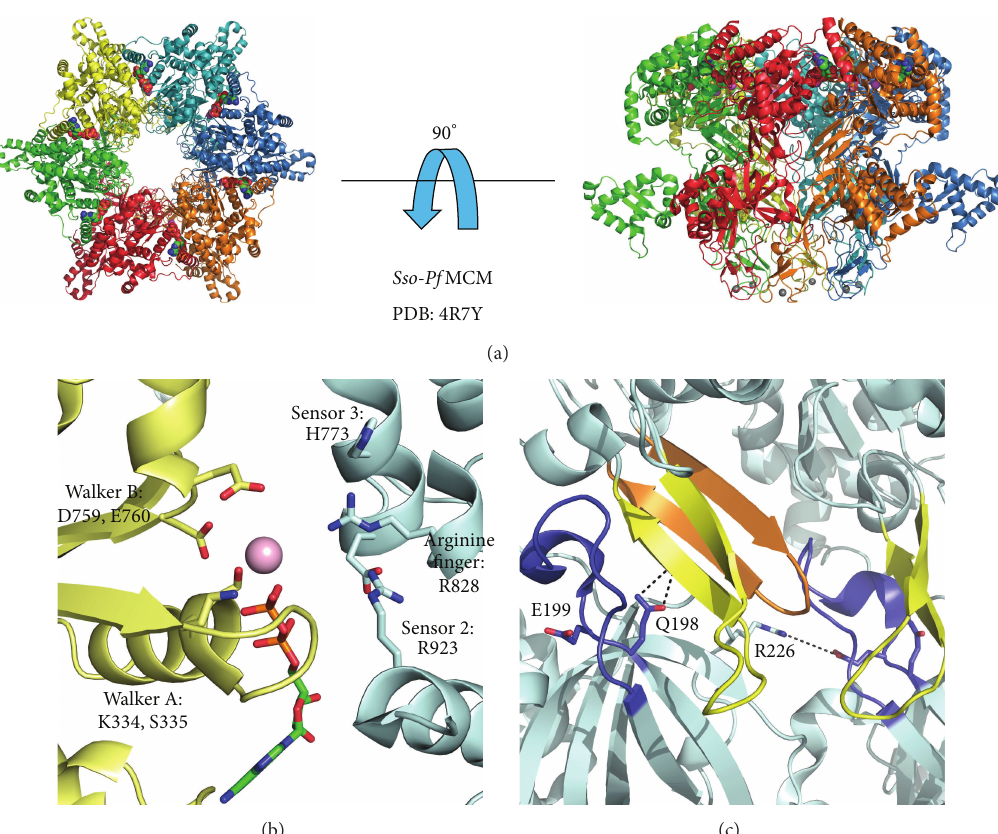
Figure 4: Crystal structure of a nearly full length MCM hexamer. An ADP-bound, nearly full length MCM protein was crystallized by creating a chimeric fusion protein of the N-terminal domain of Sso MCM and the C-terminal tier of Pf MCM. (a) Views of the Sso-Pf MCM hexamer crystal structure parallel and perpendicular to the central channel with each subunit uniquely colored. Magnesium ions are shown as magenta spheres, ADP molecules are shown in space-filling view, and zinc ions are shown as gray spheres. In the view parallel to the central channel, the ATPase domains are projected out of the page. In the perpendicular view, the ATPase domains are located at the top and the N-terminal domains are located on the bottom. (b) The ATPase site is formed at subunit interfaces by cis - and trans -acting residues shown in stick and labeled. The Walker A and Walker B residues of one subunit are positioned at the left side of the site (yellow), while three basic residues are located on the right side of the site (blue). The bound ADP molecule is shown in stick, and the magnesium ion is represented as a magenta sphere. (c) Residues of the allosteric communication loop (ACL) interact across subunit interfaces and also with main-chain atoms of the helix-2-insert (h2i) 𝛽 -hairpin motif. The ACL is shown in blue and the h2i and presensor-1- 𝛽 -hairpin (ps1 𝛽 ) are shown in yellow and orange, respectively. Dashed lines indicate the discussed molecular interactions. All structure representations of Figure 4 were prepared with the Pymol software package [88] and PDB accession code